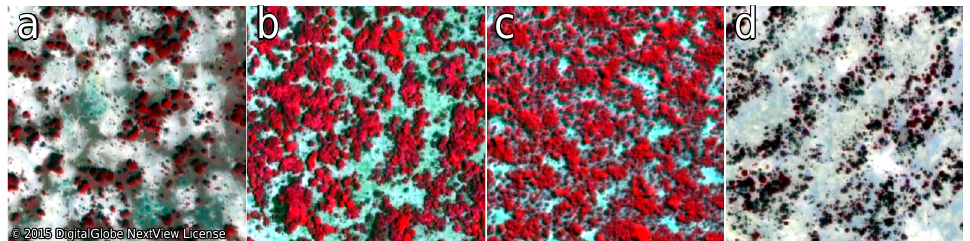
Figure 4. False-color imagery of periodic vegetation patterns identified among the sites: (a) spotted pattern in Senegal, (b) labyrinthine pattern in Mali, (c) gapped pattern in Niger, and (d) banded pattern in Somalia. Sites with PVPs were identified visually by the